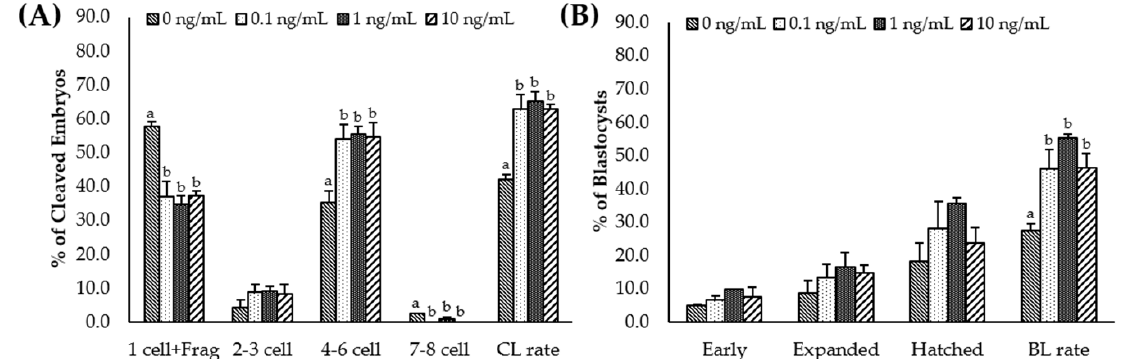
Figure 4. Effect of interleukin-7 supplementation on the cleavage pattern during in vitro maturation ( A ) and the blastocyst formation pattern ( B ) of the parthenogenetic activation (PA) embryo. Within each end point, bars with different letters (a, b) differ significantly ( p < 0.05) for different concentrations of IL-7. CL, cleavage; BL, blastocyst. The cleavage and blastocyst rates were evaluated on day 2 and 7 after PA, respectively. The experiment was replicated three times.